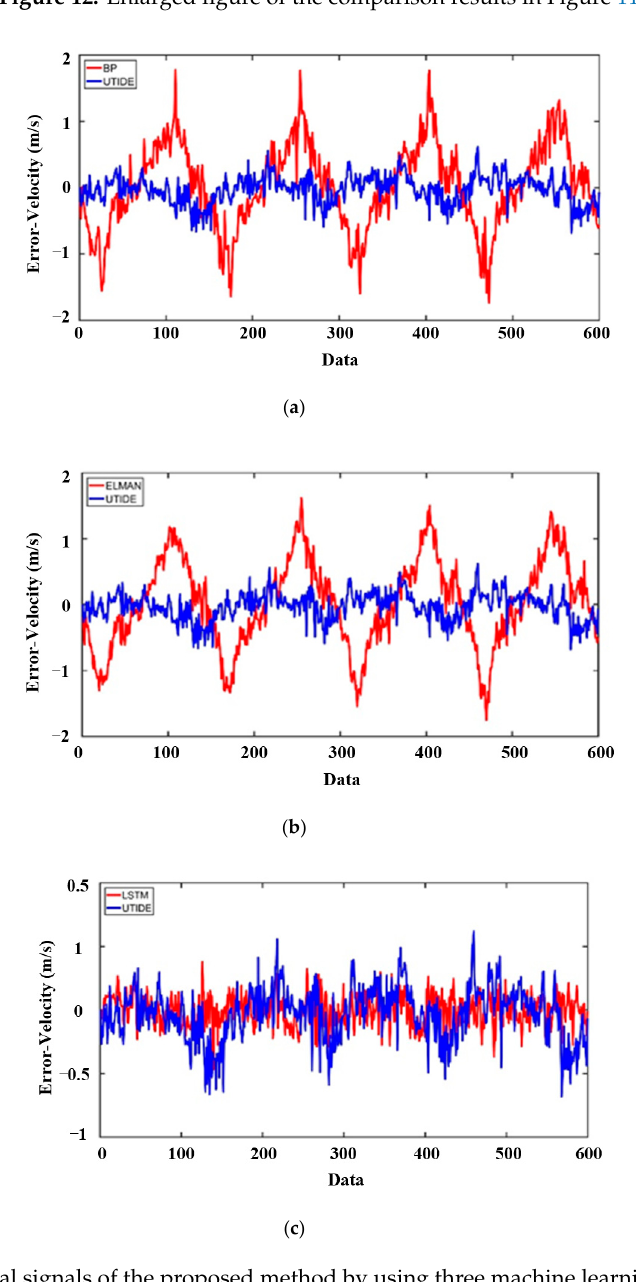
Figure 13. Residual signals of the proposed method by using three machine learning algorithms and UTide (20 m under sea surface). ( a ) Residual signals by using BP and UTide, ( b ) Residual signals by using ELMAN and UTide, ( c ) Residual signals by using LSTM and UTide.